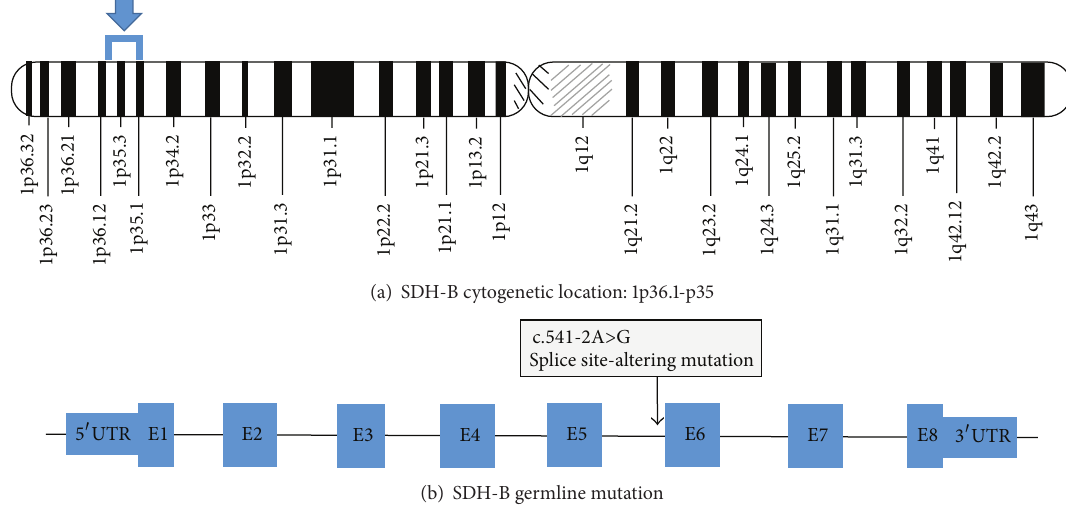
Figure 3: Chromosomal location of the SDHB gene (a) and site of the patient’s specific mutation (b).